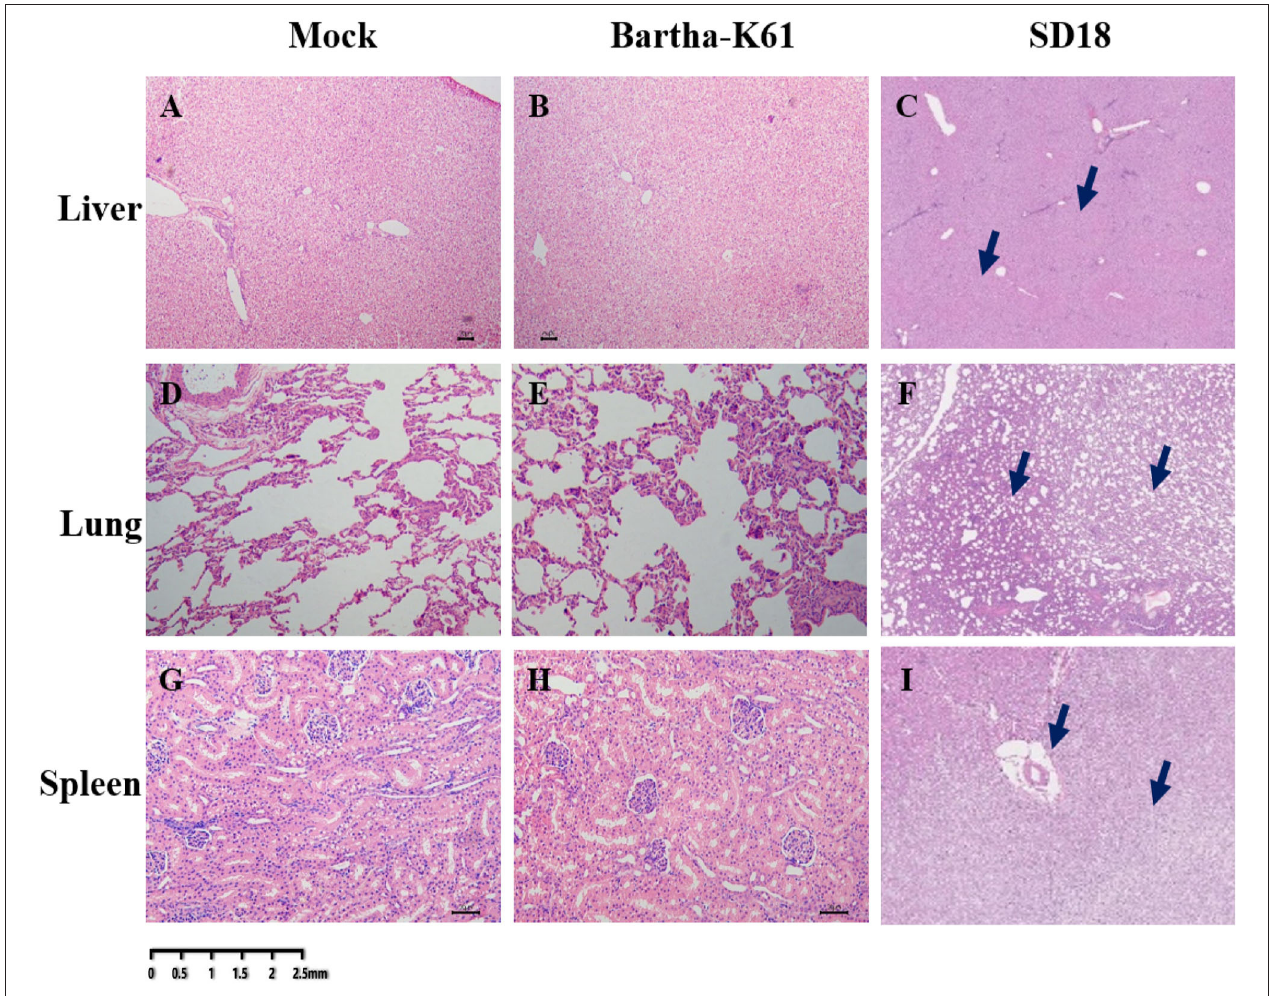
FIGURE 3 | Histological changes in PRV-infected cats. Affected tissues collected from the mock-, BarthaK61, and SD18-infected cats were used for histological analysis. Histological changes were examined by light microscopy. (A–C) Histological changes of the liver. (D–F) Histological changes of the lung. (G–I) Histological changes of the